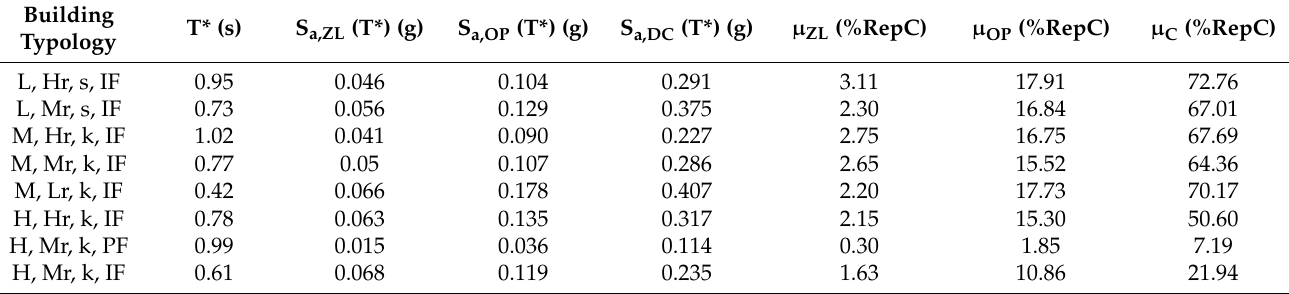
Table 10. Main results obtained using the DEAL